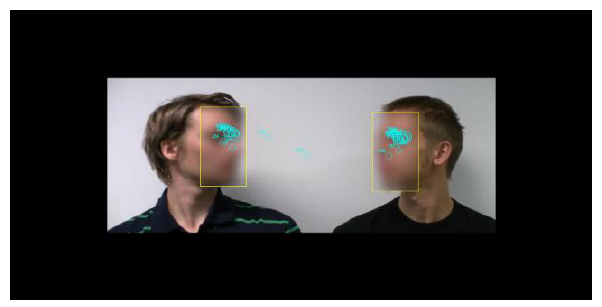
Figure 1. Screenshot from a stimulus video overlaid with area- of-interest and fixation position data from a single trial. Faces are blurred in this figure for making the actors unidentifiable. In the actual stimuli the faces were not